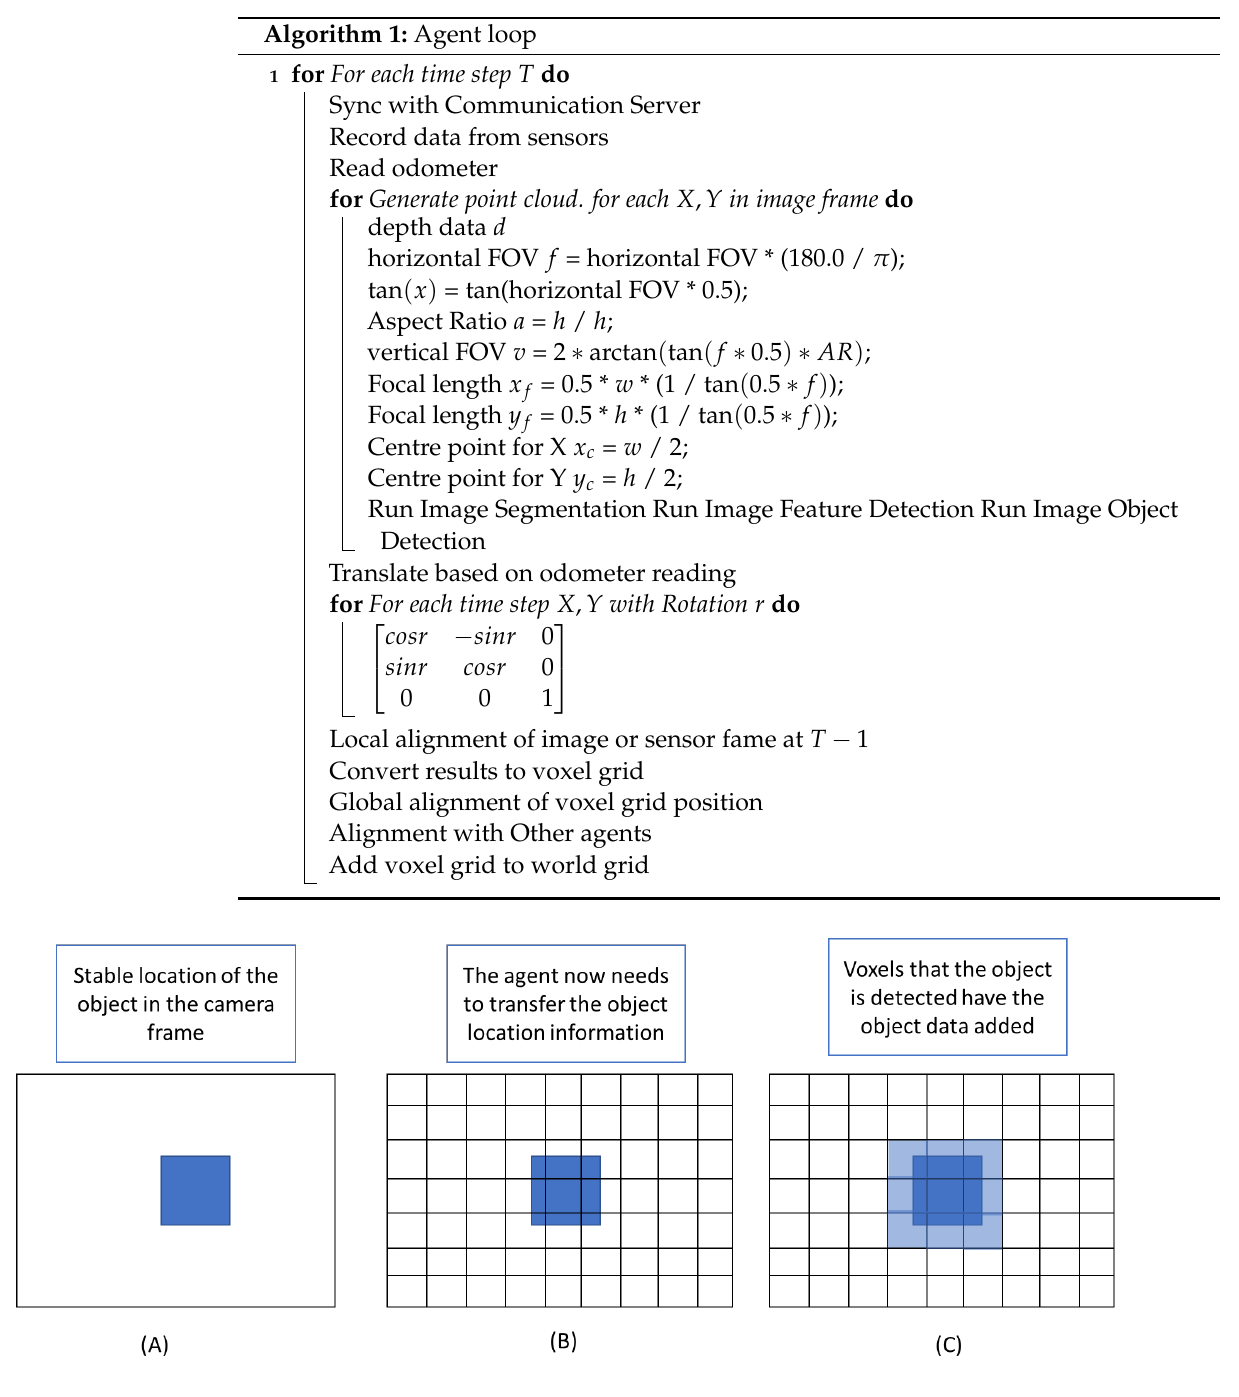
Figure 1. Figure illustrating an object overlaid with a voxel grid in 2D. ( A ) displays the object within its environment, while ( B ) depicts the voxel grid layered on top of the environment. ( C ) shows the voxels associated with the object displayed within the voxel